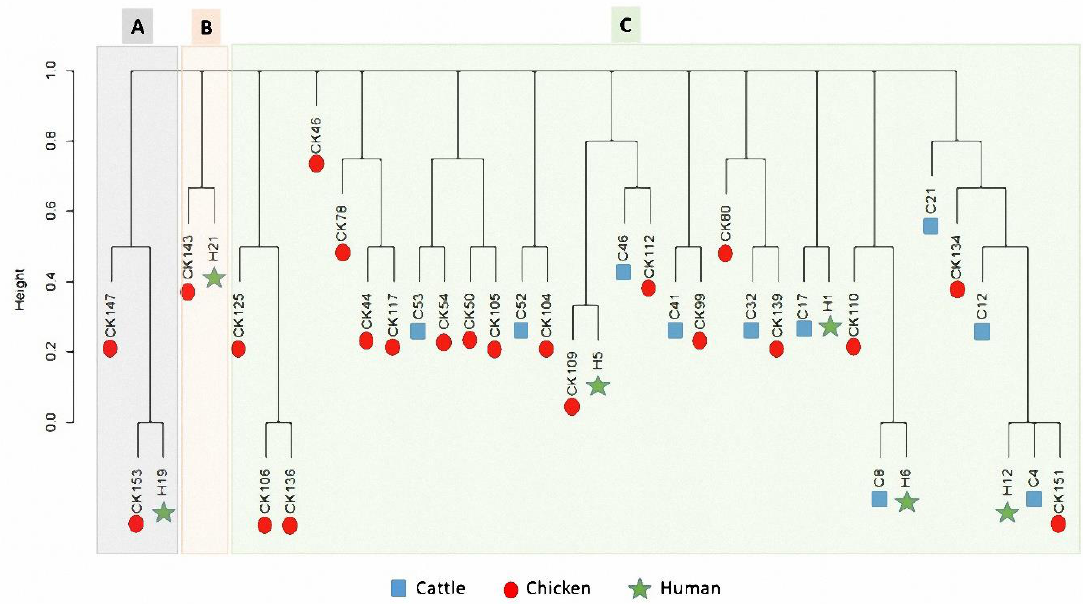
Figure 3. Dendrogram showing the binary distances among different Campylobacter isolates based on the integron patterns. The isolates are categorized based on their host, which are shown as different colors and symbols. The X -axis refers to the binary distance scale. Isolates codes are illustrated in Table 4.